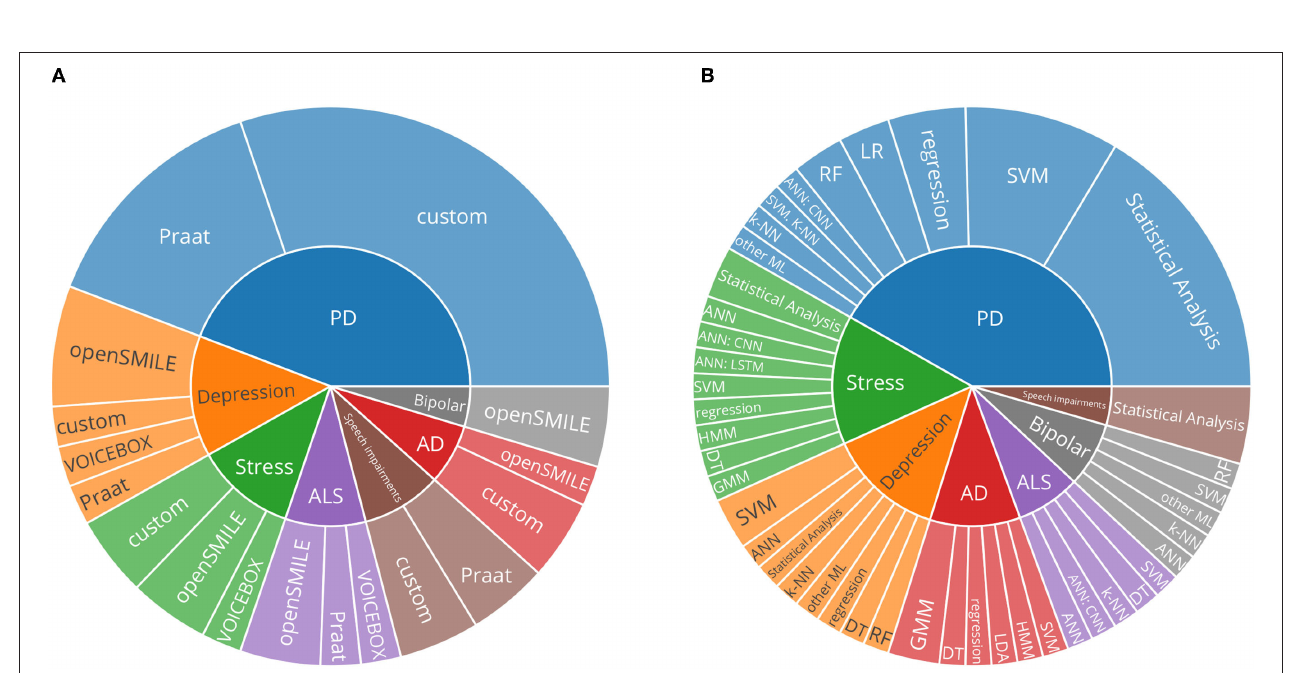
FIGURE 4 | (A) Sunburst chart describing the proportion of feature extraction toolkits used and neurological disorders. ‘Custom’ describes studies which did not mention the toolkit used or which utilised custom methods to extract features. (B) Sunburst chart describing the proportion of predictive modeling approaches used and neurological disorders. Categorical classification: SVM, support vector machines; k-NN, k-nearest neighbors algorithm; DT, decision trees; RF, random forests; GMM, Gaussian Mixture Models; HMM, Hidden Markov Models; Regression models: LR, linear regression; regression: other regression methods. ANNs, Artificial neural networks; CNN, convolutional neural networks; LSTM, long short-term memory networks; PD, Parkinson’s disease; AD, Alzheimer’s disease; ALS, amyotrophic lateral sclerosis.